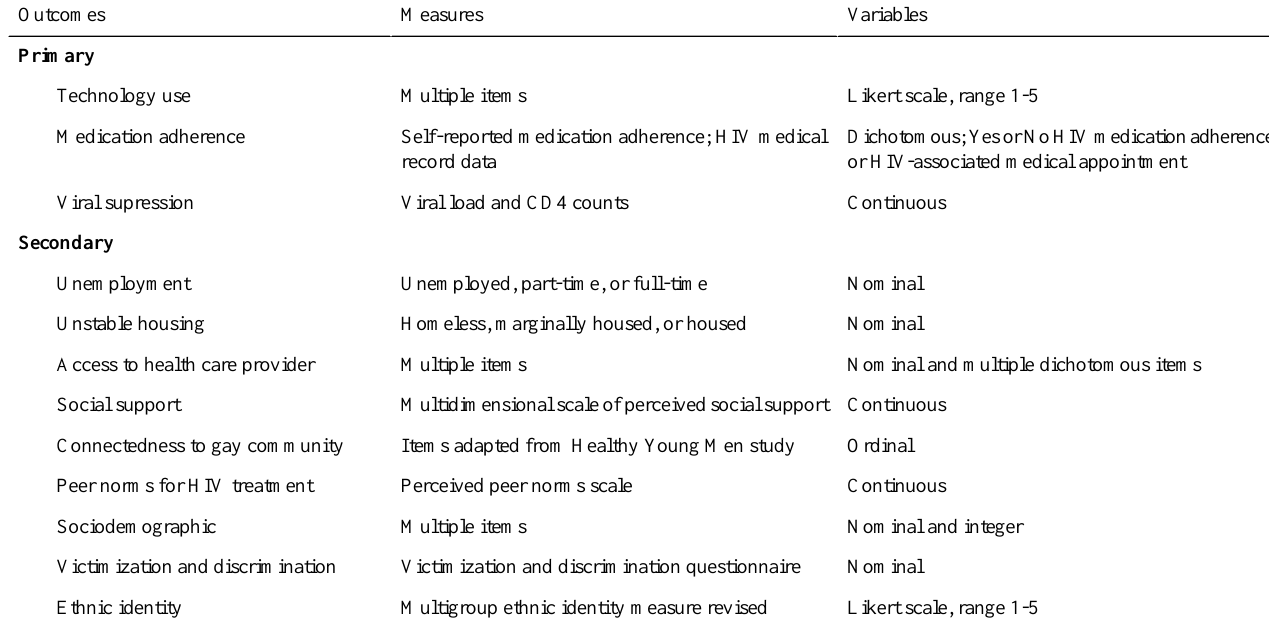
Table 1. Primary and secondary outcomes of the study.